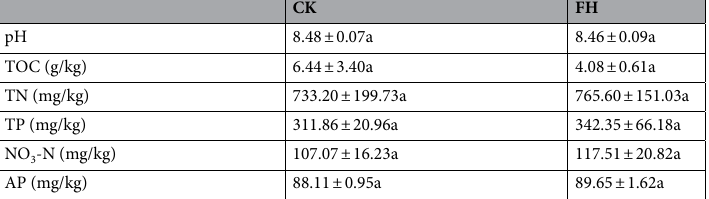
Table 2. Effects of Bacillus amyloliquefaciens FH-1 inoculation on rhizosphere soil properties. Values (means ± SD, n = 5) within the same row followed by different letters are significantly different at P < 0.05 according to Independent-Samples t Test. TOC total organic carbon, TN total nitrogen, TP total phosphate, NO 3 -N nitrate nitrogen, AP available phosphate, CK non-inoculated, FH inoculated with Bacillus amyloliquefaciens